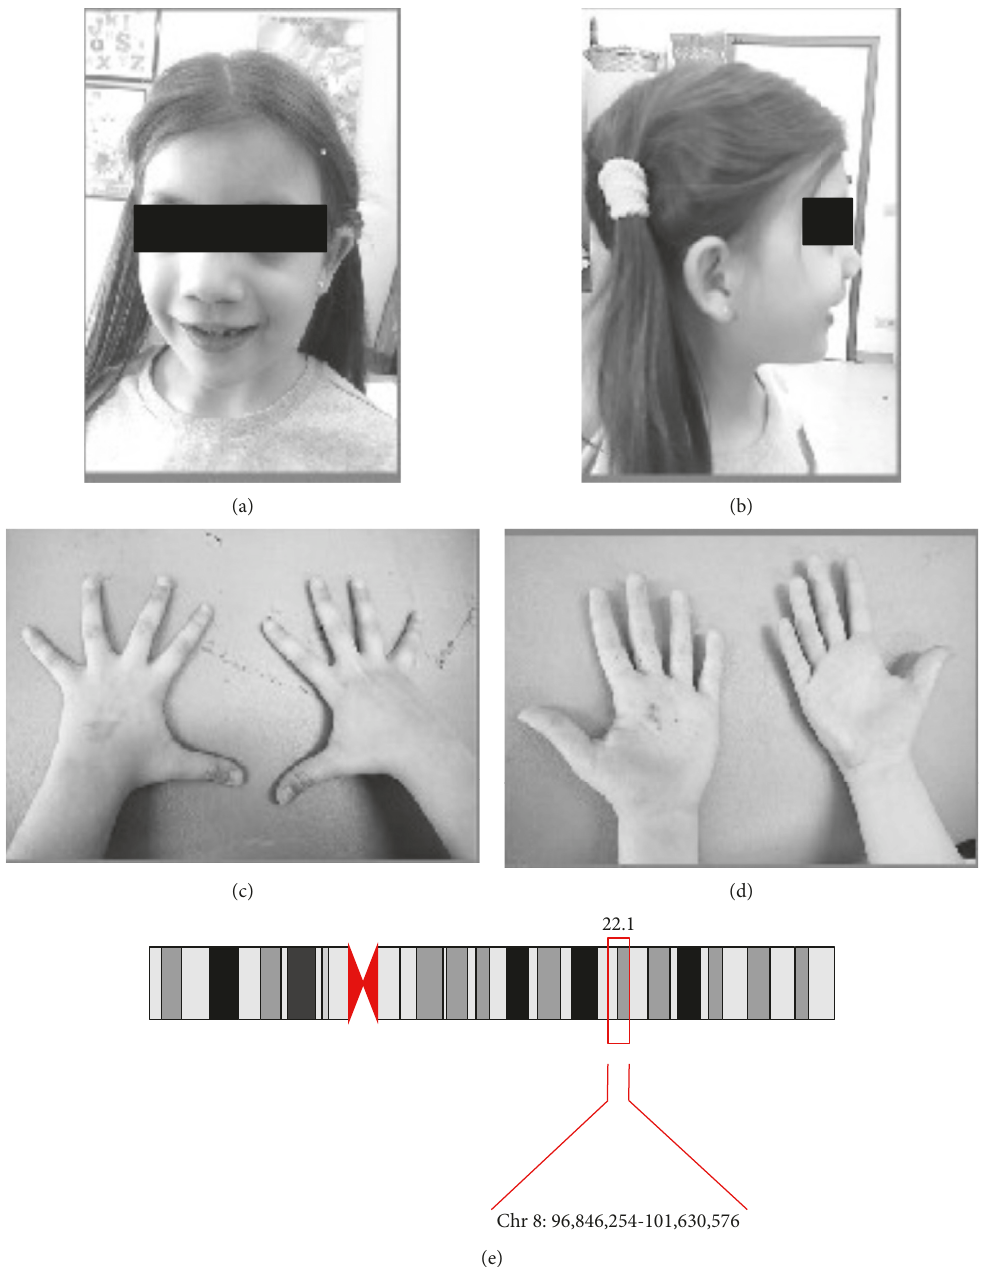
Figure 1: (a, b) Facial picture of the 8-year-old girl showing facial dimorphism: flat face, blepharophimosis, hypertelorism, broad nasal bridge, and high palate. (c, d) Hands photograph showing bones and joints defects: single transverse palmar crease and brachydactyly. (e) The 8p22.1 microduplication and its coordinates in our